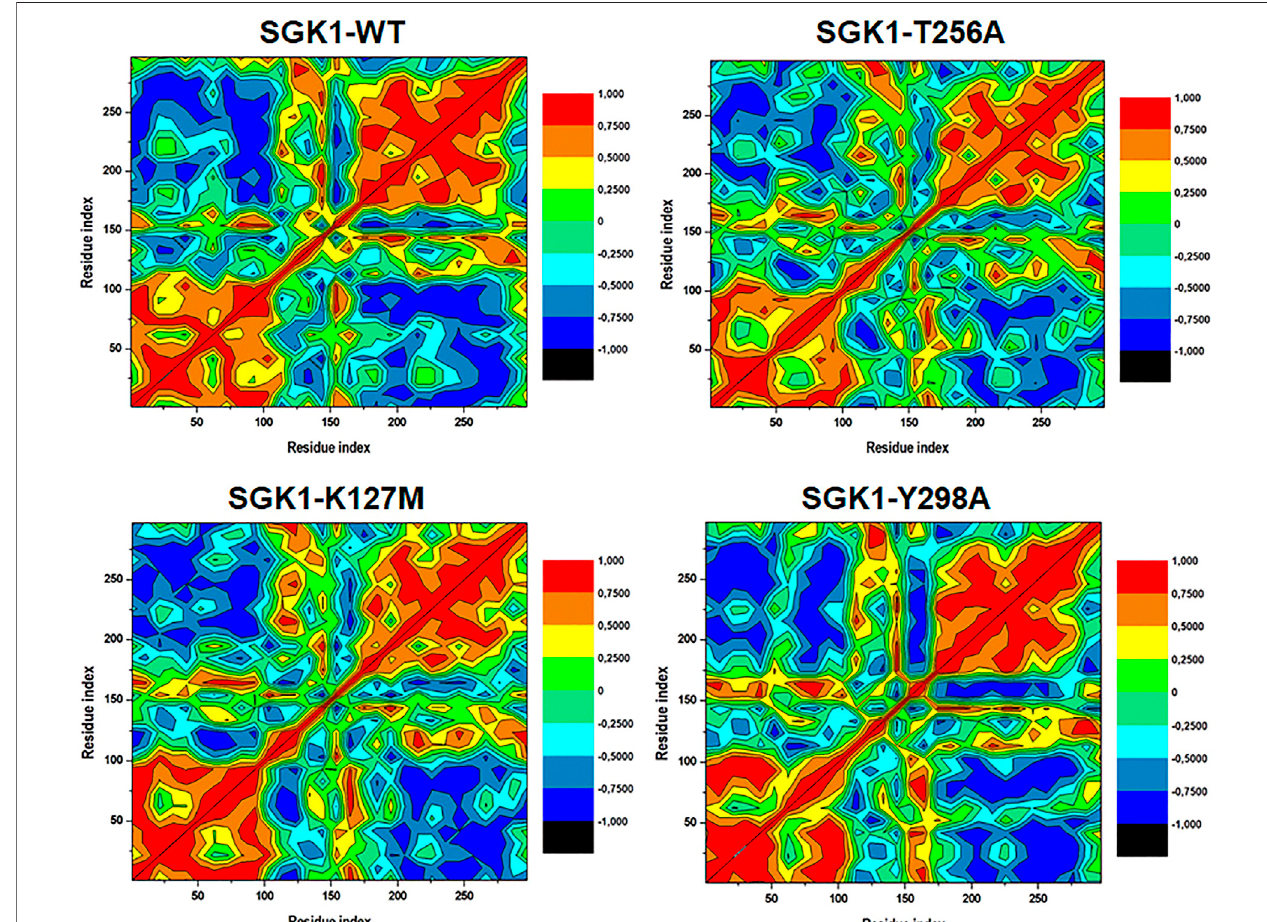
FIGURE 9 | Dynamics cross-correlation matrices of SGK1-WT, K127M, T256A, and Y298A generated from 200 ns of MD trajectories.